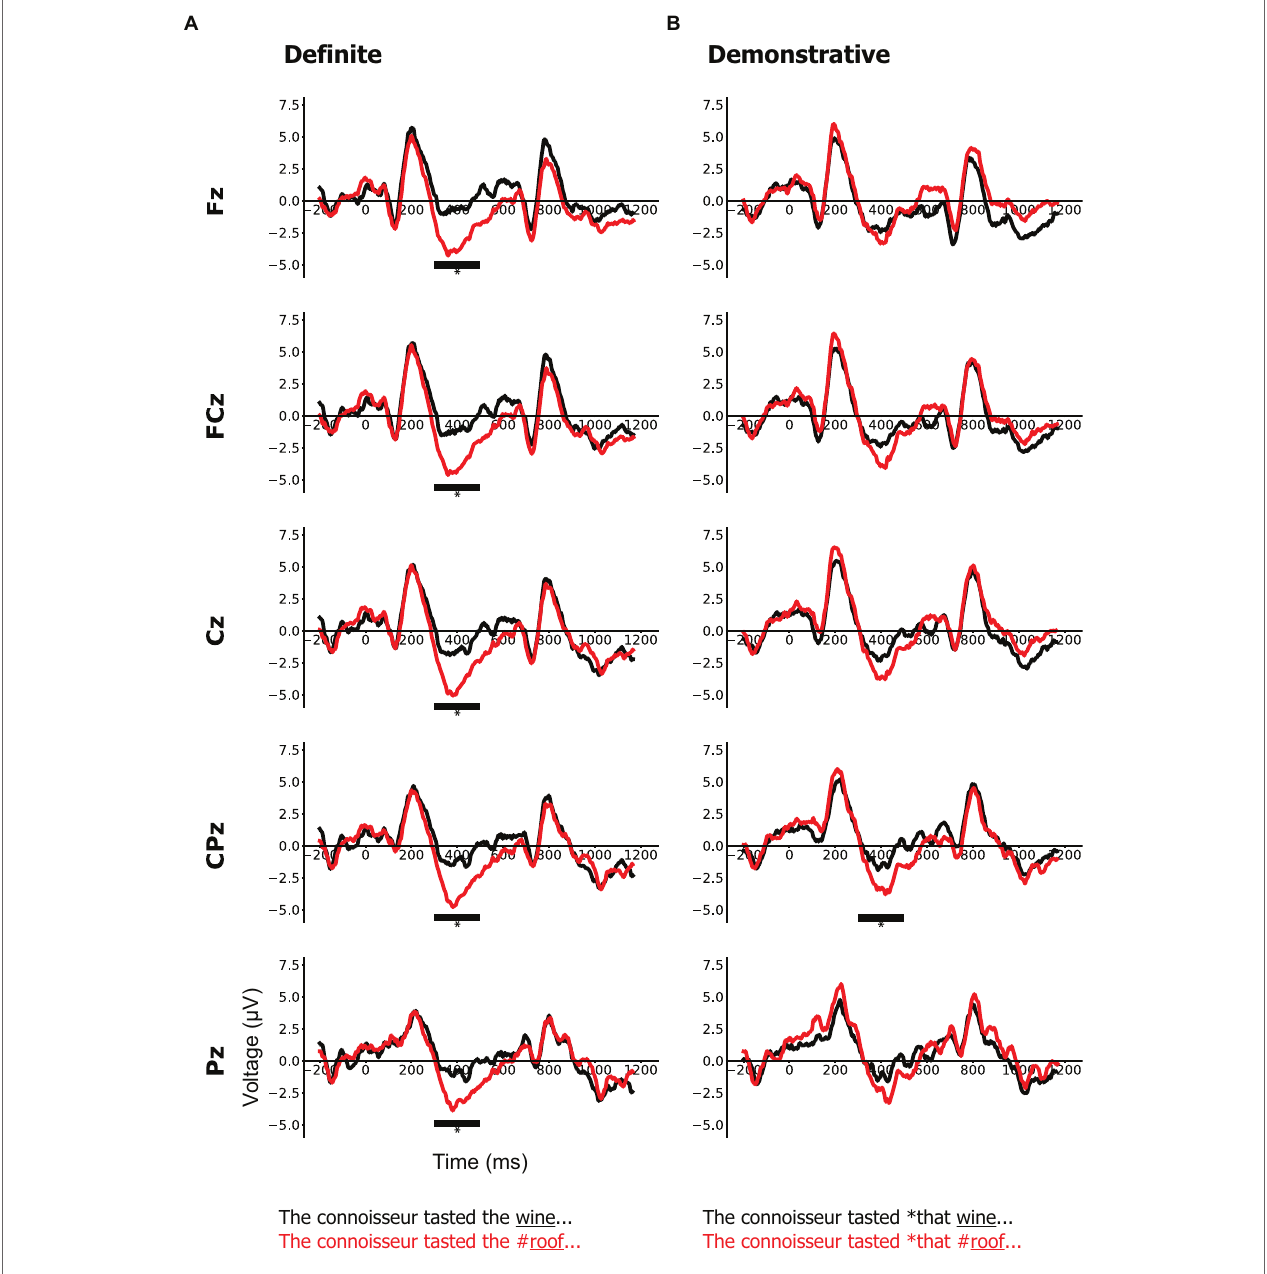
FIGURE 3 | Grand average event-related potential (ERP) waveforms for object type condition: congruent (black) and incongruent (red) separately for definite (A) and demonstrative (B) conditions at five midline electrodes (Fz, FCz, Cz, CPz, and Pz) time-locked to the onset of the critical word ( wine/#roof ). Asterisks * indicate significant amplitude differences (see Section “N400 at the critical